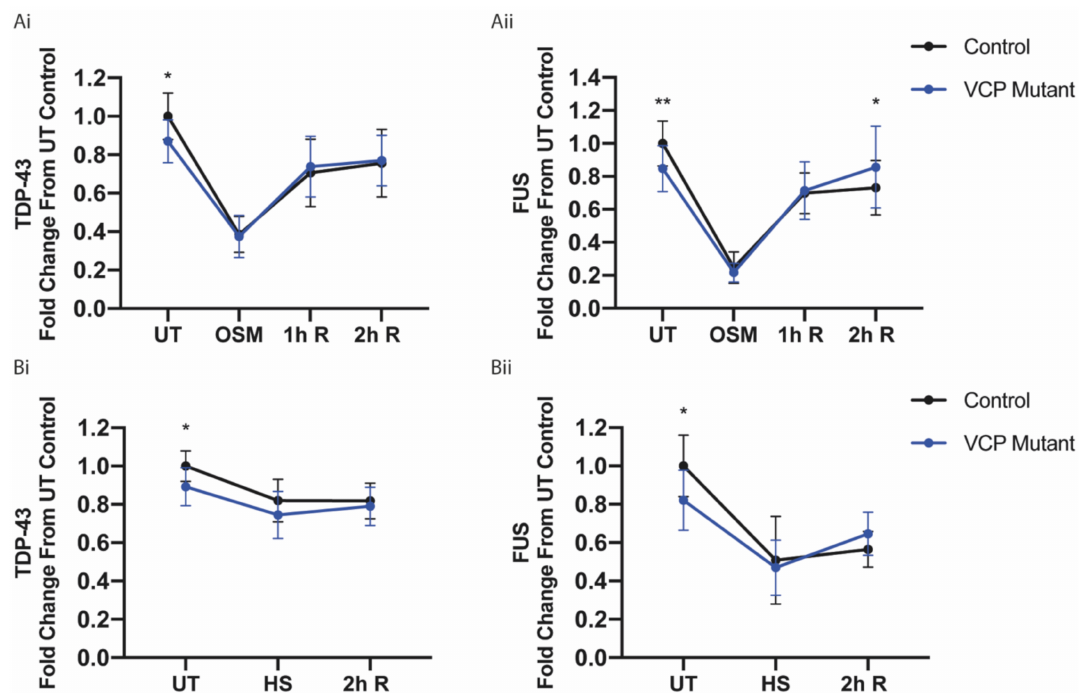
Figure 6. Human iPSC-derived VCP mutant motor neurons do not show perturbed TDP-43 and FUS redistribution upon stress and recovery. ( A ) Control and VCP mutant motor neurons were treated with 0.4 M sorbitol and then allowed to recover for 1-h (1h R) and 2-h (2h R) time periods. Individual cell analysis was used to quantify RBP nuclear / cytoplasmic ratio, which was then calculated as fold change over control untreated (UT) values for each experimental repeat. Data are plotted in a line graph as mean fold change ( ± SD) per well from > 10,000 cells from 3 control lines and > 20,000 cells from 4 VCP mutant lines for each experimental condition across 3 independent experiments. p -values displayed are from a Sidak’s multiple comparison test (* p < 0.05, ** p < 0.01). ( Ai ) For TDP-43, VCP mutant motor neurons show a loss in the nuclear-to-cytoplasmic ratio under untreated conditions but no di ff erence in nucleocytoplasmic distribution upon osmotic stress or after recovery. ( Aii ) For FUS, VCP mutant motor neurons show a loss in the nuclear-to-cytoplasmic ratio under untreated conditions but no di ff erence in protein localisation upon osmotic stress or after 1 h of recovery. Following 2 h of recovery, VCP mutant motor neurons show an increased degree of nuclear relocalisation. ( B ) Control and VCP mutant motor neurons were subjected to 42 ◦ C for 1 h to cause heat stress (HS), and motor neurons recovered for 2 h following heat stress at 37 ◦ C (2h R). Quantification was performed in the same manner as above. Data are plotted in a line graph as mean fold change ( ± SD) from > 7000 cells from 3 control lines and > 10,000 cells from 4 VCP mutant lines across 2 independent experimental repeats. p -values displayed are from a Sidak’s multiple comparison test (* p < 0.05). ( Bi ) VCP mutant motor neurons showed a loss in the nuclear-to-cytoplasmic ratio of TDP-43 under basal conditions but no di ff erence upon heat stress or 2 h recovery. ( Bii ) VCP mutant motor neurons showed a loss in the nuclear-to-cytoplasmic ratio of FUS under basal conditions but no di ff erence upon heat stress or 2 h